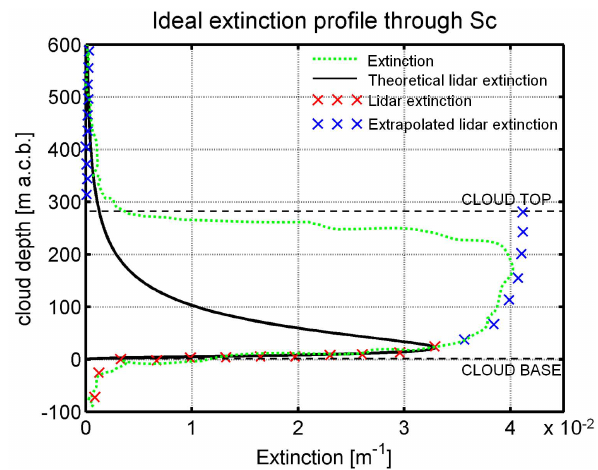
Fig. 3. Black solid: log-normal ideal extinction profile through the cloud layer; red crosses: lidar-retrieved σ -points; green dashed: not fully attenuated extinction profile; blue crosses: power-law extrap- olated σ -points; black dashed: cloud top and base